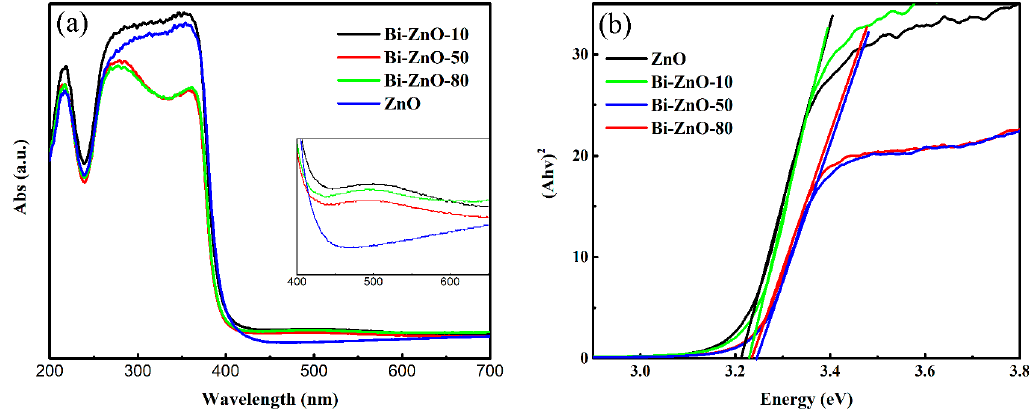
Figure 5. ( a ) DRS spectra and ( b ) plots of (Ahv) 2 versus hv for ZnO and BiNPs/ZnO anocomposites.